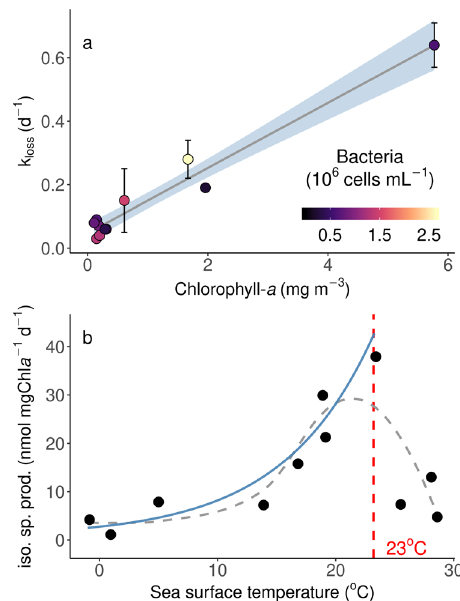
Fig. 3 Isoprene processes and their main drivers. a Rate constant of isoprene loss in dark incubations ( k loss , considered to be microbial and chemical consumption) vs. chlorophyll-a concentration. The linear regression equation is k loss = 0.10 × [chl a ] + 0.05 ( R 2 = 0.96, p = 10 − 7 , n = 11). The standard error of the slope is 0.01 L mg − 1 d − 1 , and the standard error of the intercept is 0.01 d − 1 . Error bars represent the experimentally determined standard error of k loss . The colour scale of the circles indicates bacterial abundances. b Speci fi c (chl a -normalised) rate of isoprene production vs seawater temperature (SST) across the sample series. The dashed line is the general smoothed trend. The blue line is the exponential adjustment at SST <23 °C: isoprene sp.prod. = 2.04 × e (0.13·SST) + 0.71 ( R 2 = 0.85, p = 10 − 3 , n = 8). marine isoprene cycling, replacing the fi xed term for microbial